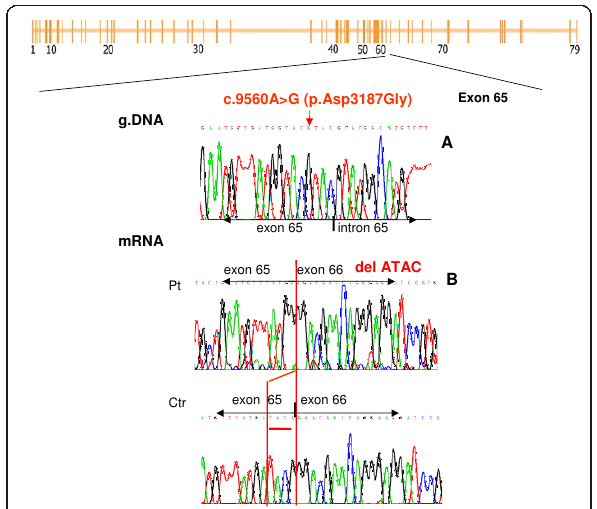
Figure 5 Patient XXXV: Coding region point mutation activates a cryptic exonic splice site . The mutation is localized in exon 65 (see schematic representation of the DMD gene). A. Sequence analysis. An electropherogram depicting the nucleotide substitution c.9560A>G, which would putatively result in an amino acid substitution (p.Asp3187Gly). B. Transcript analysis. The nucleotide substitution activates a cryptic splice site with skipping of the last 4 nucleotides of exon 65 (Pt: patient; Ctr: control), which changes the reading